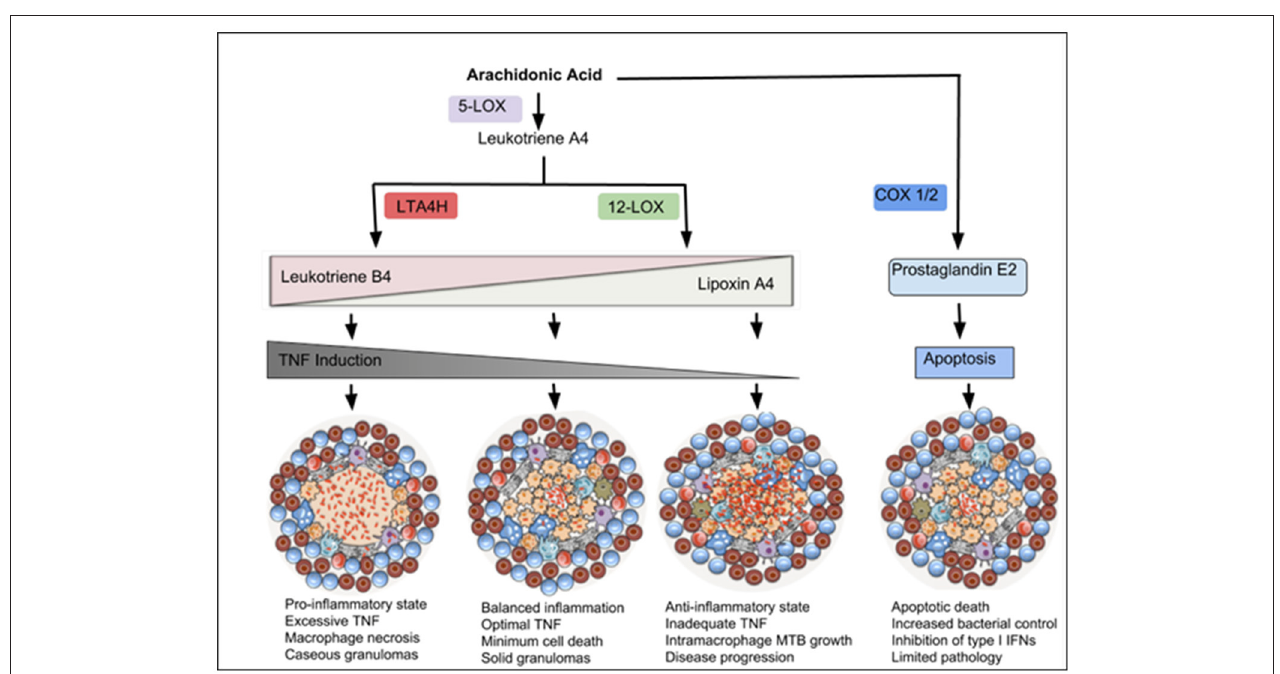
FIGURE 3 | Eicosanoids drive inflammatory responses that modulate macrophage cell death and TB disease outcome. Arachidonic Acid (AA) can be metabolized by 5-LOX to produce Leukotriene A4 (LTA4), which is a precursor of Leukotriene B4 (produced via an enzyme LTA4H) or Lipoxin A4 (produced via 12-LOX). Leukotriene B4 (LTB4) induces pro-inflammatory responses and TNF expression, which in excess, promotes macrophage necrosis and granuloma caseation. Lipoxin A4 (LXA4) is anti-inflammatory and associated with TNF deficiency and increased intra-macrophage bacterial growth. Balanced amounts of these pro- and anti-inflammatory lipid mediators are required for optimal control of cell death and disease progression. AA can also be metabolized by COX-1/2 to produce Prostaglandin E2, which induces macrophage apoptosis and promotes antimicrobial